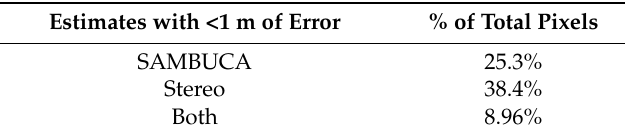
Table 2. Total % of accurate pixels for each algorithm, and % of pixels for which both algorithms are accurate.